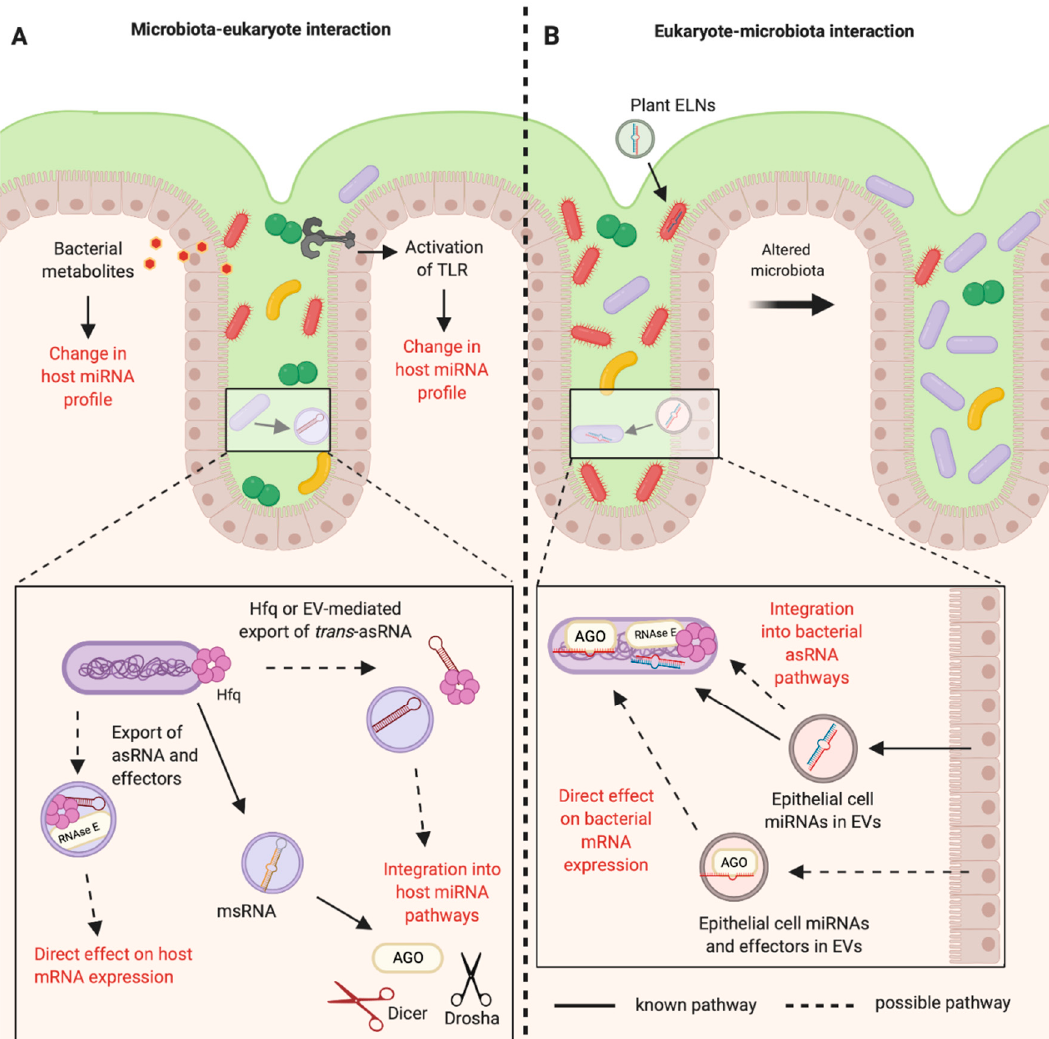
Figure 2. RNA-mediated communications between the mammalian host and the bacteria of the gastrointestinal microbiota. ( A ) The bacteria of the mammalian intestinal microbiota can indirectly alter the host miRNA profile through the production of metabolites and activation of Toll-like Receptors (TLRs). It is known that bacteria can produce microRNA-size RNAs (msRNAs) in Extracellular Vesicles (EVs) that can integrate into host miRNA pathways [47]. Other RNAs such as trans- asRNAs could be exported in vesicles and could similarly integrate into host pathways. It is also possible that asRNAs could be exported along with their effectors in EVs (such as Hfq and RNase E) and could directly influence host gene expression. EV-independent export of asRNAs could be mediated by Hfq, as Hfq can create holes in the bacterial cell membrane [79]. (B ) Plant exosome-like nanoparticles (ELNs) from diet and EVs from intestinal epithelial cells containing miRNAs can enter members of the microbiota and influence bacterial gene expression and growth [14,16]. These miRNAs could be exported with effectors such as Argonaute (AGO) to directly alter bacterial gene expression. Alternatively, eukaryotic miRNAs could become functional upon integration into existing bacterial asRNA regulatory pathways.